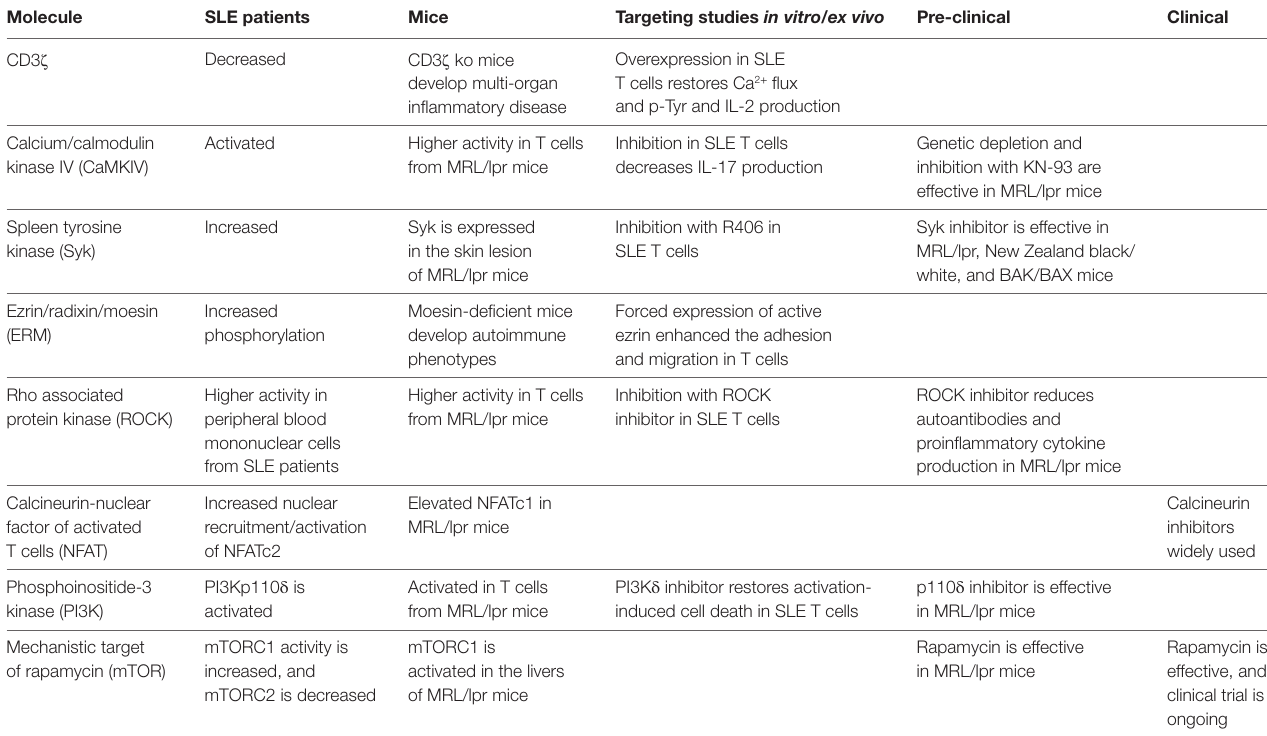
TAbLe 1 | Signaling molecules as potential therapeutic targets for systemic lupus erythematosus